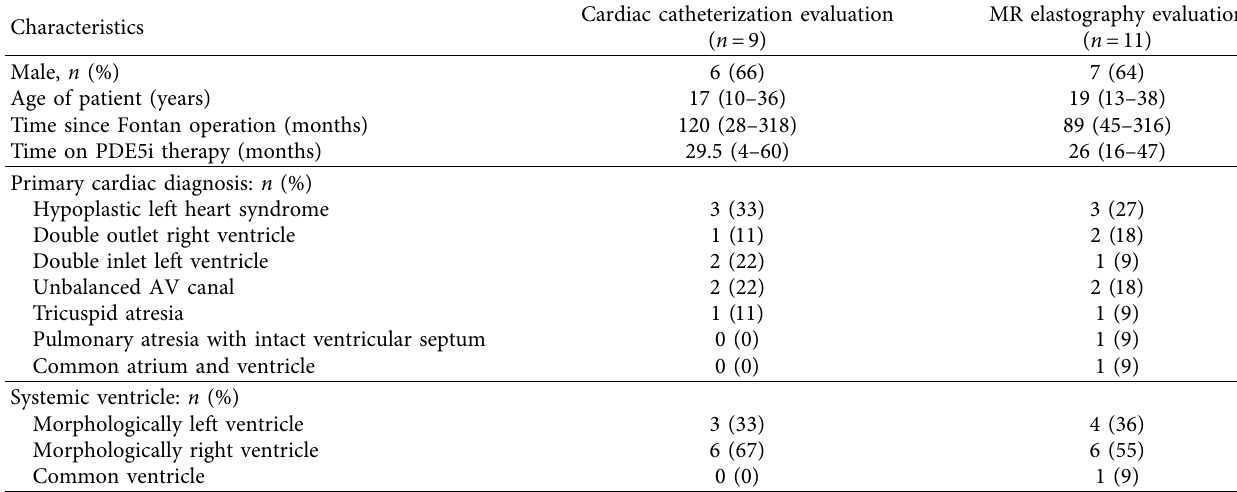
Table 1: Summary of patients who underwent pretherapy and posttherapy evaluations.